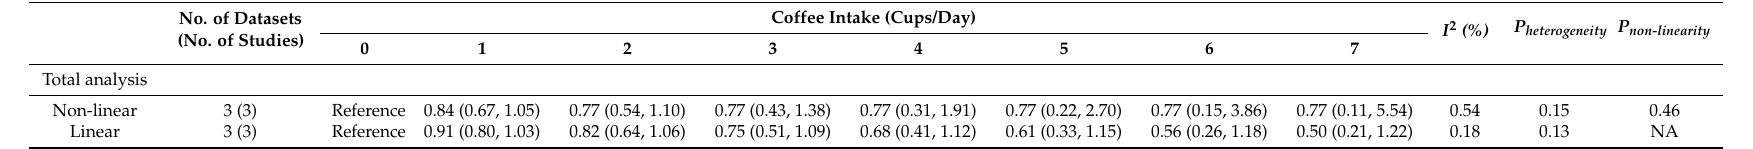
Table 3. Dose–response meta-analysis of prospective cohort studies on coffee consumption and biliary tract cancer risk.